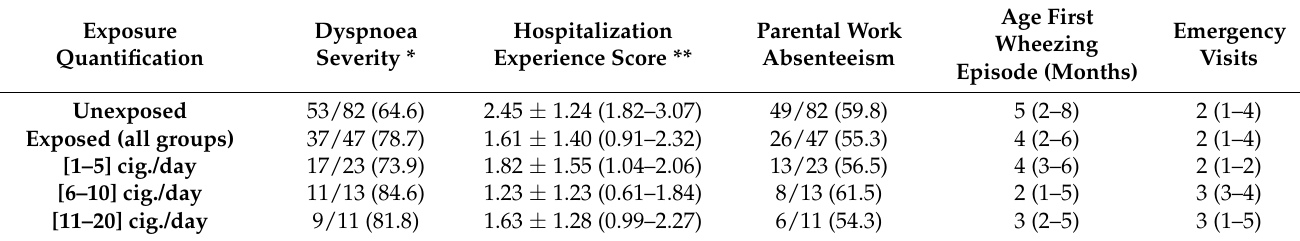
β : regression coefficient; PTSE: Prenatal Tobacco Smoke Exposure. Table 5. Secondary